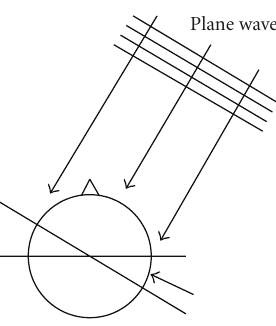
Figure 2: The rigid ball model of human head used by Rayleigh.